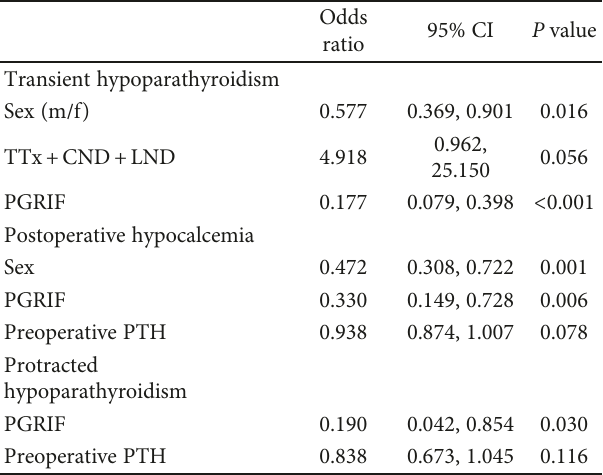
Table 2: Independent risk factor identi fi cation of postoperative hypocalcemia and transient and protracted